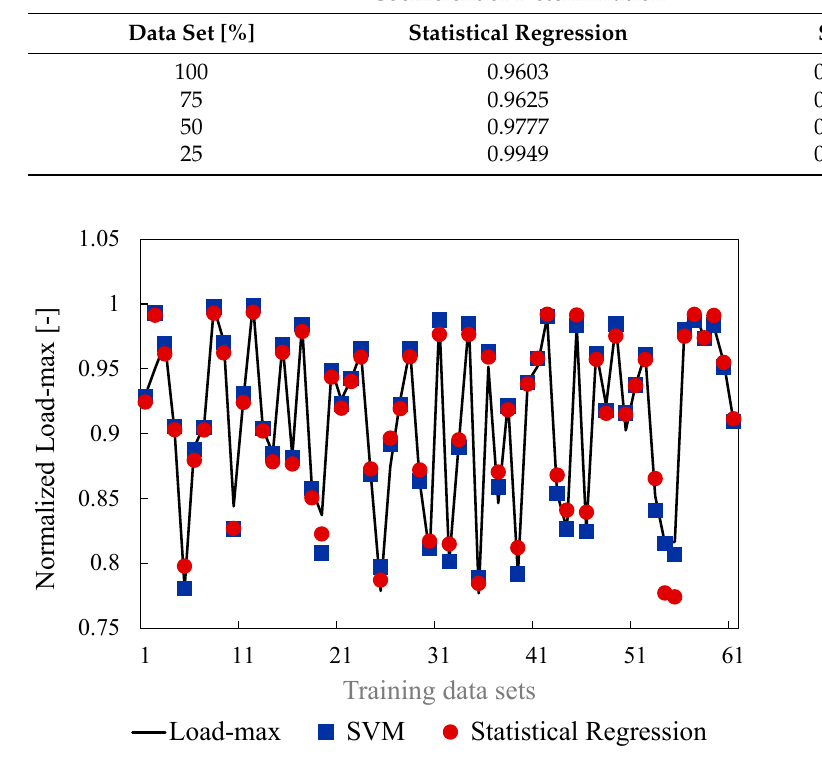
Figure 13. Normalized Load-max vs. training datasets for different regression method.